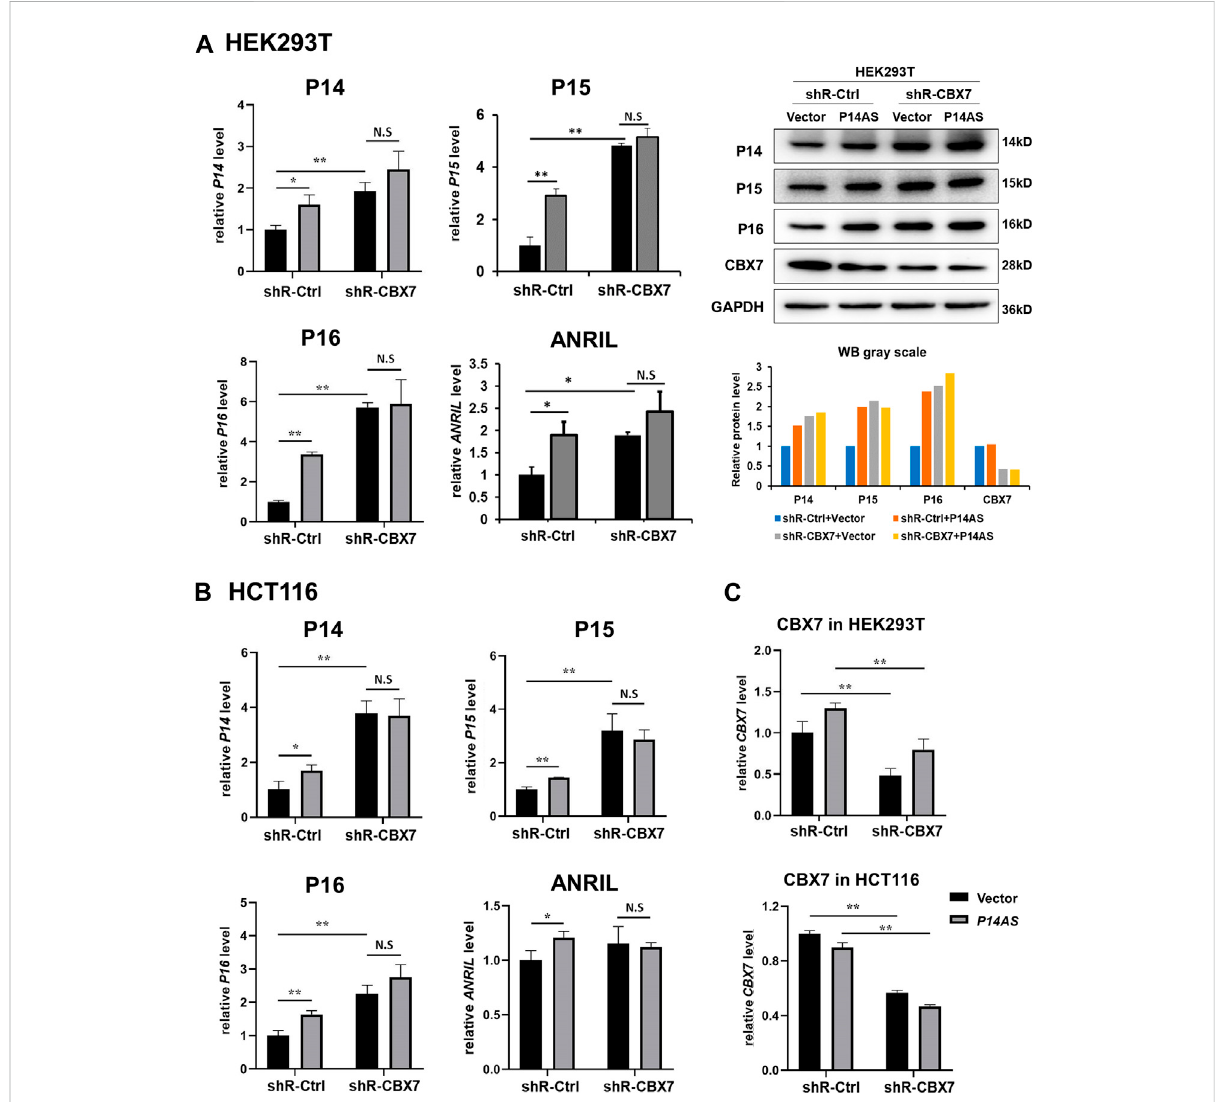
FIGURE 4 Downregulation of CBX7 expression disables P14AS to upregulate the P14 ARF , P15 INK4B , P16 INK4A expression levels in HEK293T and HCT116 cells with active basal CBX7 expression in qRT-PCR and Western blot analyses. (A) HEK293T; (B) HCT116 cells; (C) the ef fi ciency of CBX7 knockdown in HEK293T and